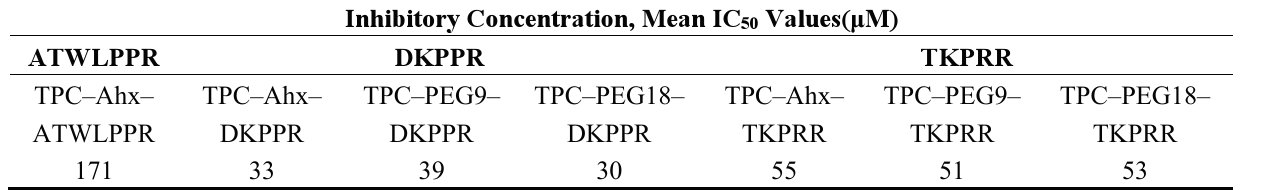
Table 4. IC 50 (half maximal inhibitory concentration) values.